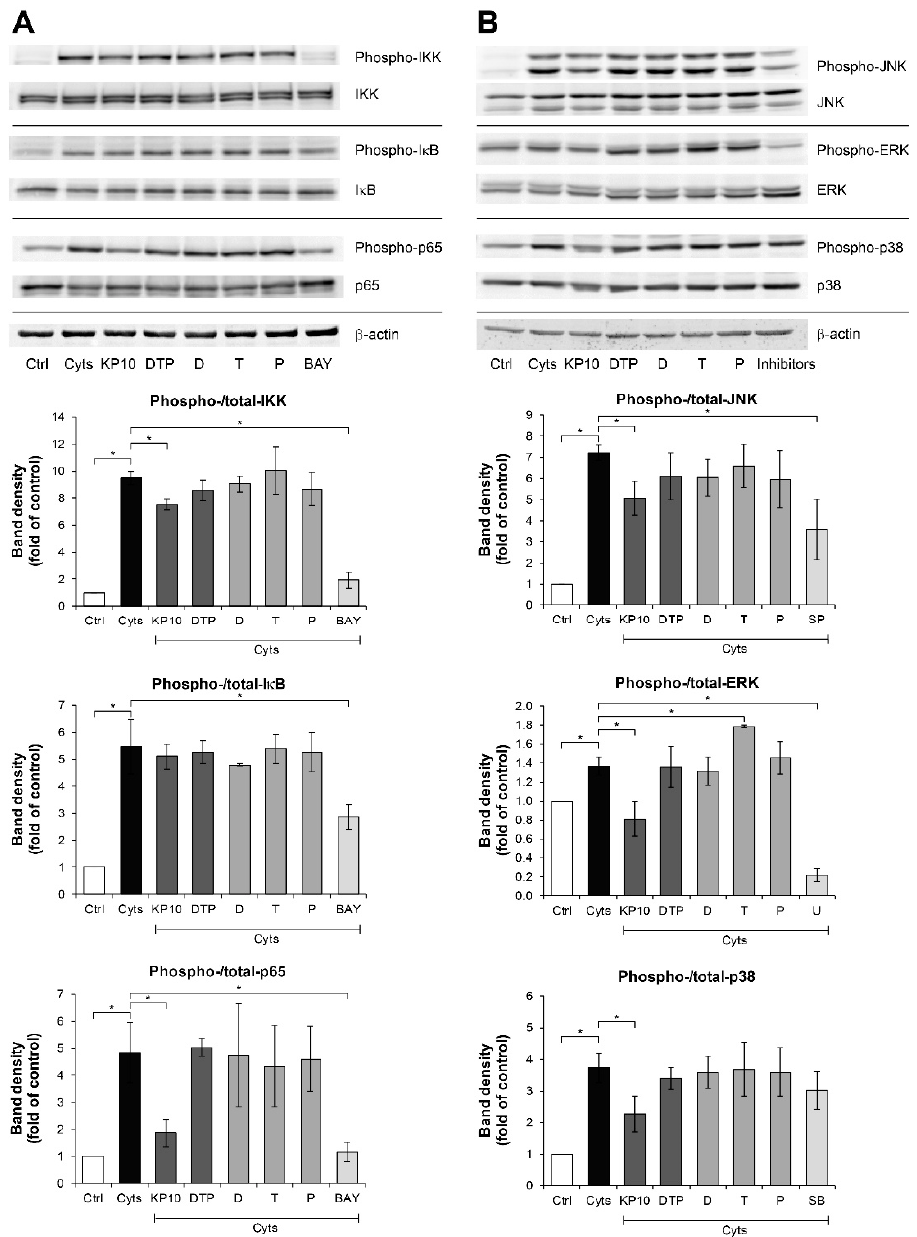
Figure 4. KP extract suppresses the NF- κ B and MAPK pathways in SW1353 cells. SW1353 cells were pretreated for 2 h with KP extract (10 μ g/mL), 5,7-dimethoxyflavone (D; 3.3 μ g/mL), 5,7,4 ′ -trimethoxyflavone (T; 2.6 μ g/mL), 3,5,7,3 ′ ,4 ′ -pentamethoxyflavone (P; 2.2 μ g/mL) and a mixture of the three major compounds (DTP), which equal to the estimated proportions in the KP extract at 10 μ g/mL (D: T: P = 3.3: 2.6: 2.2 μ g/mL), and signaling inhibitors, including BAY11-7082 (BAY; 20 μ M), SP600125 (SP; 10 μ M), U0126 (U; 5 μ M), and SB203580 (SB; 1 μ M). The cells were then co-treated with IL-1 β 2 ng/mL and IL-17A 4 ng/mL (Cyts) for 25–30 min. The untreated group was left as a control (Ctrl). The representative immunoblots against NF- κ B and MAPK signaling molecules are shown in ( A ) and ( B ), respectively. Bar graphs are mean ± SD of two independent experiments in the ratios between the band intensities of phosphorylated form and total form of each condition. One-way ANOVA followed by the post hoc Fisher’s test was used to analyze the statistical difference (* p < 0.05). The band density for each sample was normalized to β -actin. The full-length blot images are provided in Supplementary Data (Figures S6 and S7).